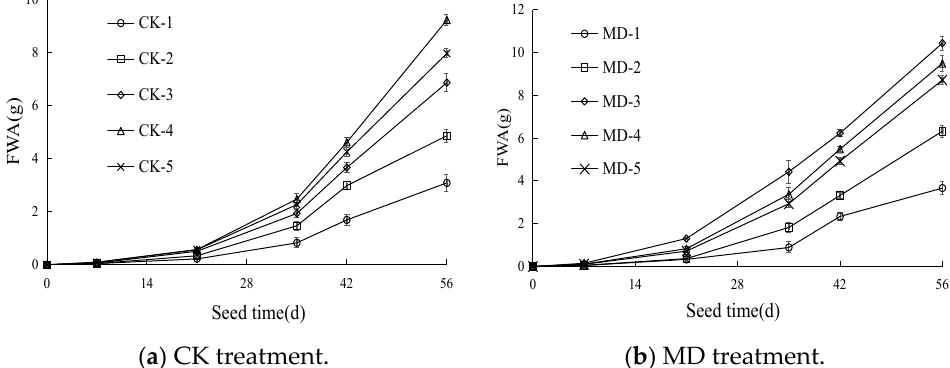
Figure 2. Dynamic changes in the fresh weight of the aerial part of spinach under different treatments. CK-1, CK-2, CK-3, CK-4, and CK-5 indicate that the soil moisture content is controlled at 45–55%, 55–65%, 65–75%, 75–85%, and 85–95% of the field capacity with conventional water,